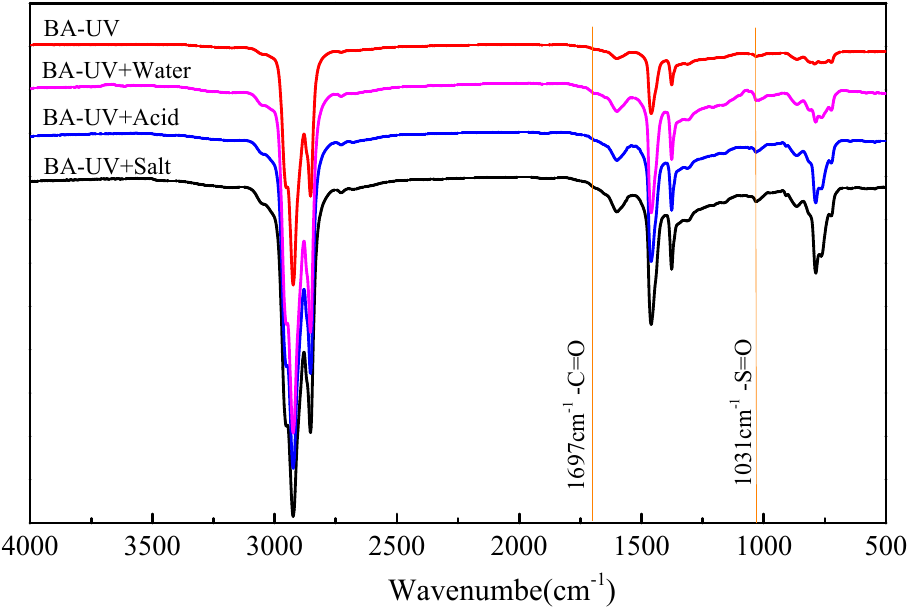
Figure 6. Fourier transform infrared spectroscopy (FTIR) spectra of base bitumen before and after UV aging in different environments.